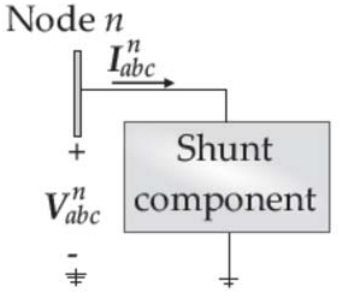
Figure 2. Shunt component.